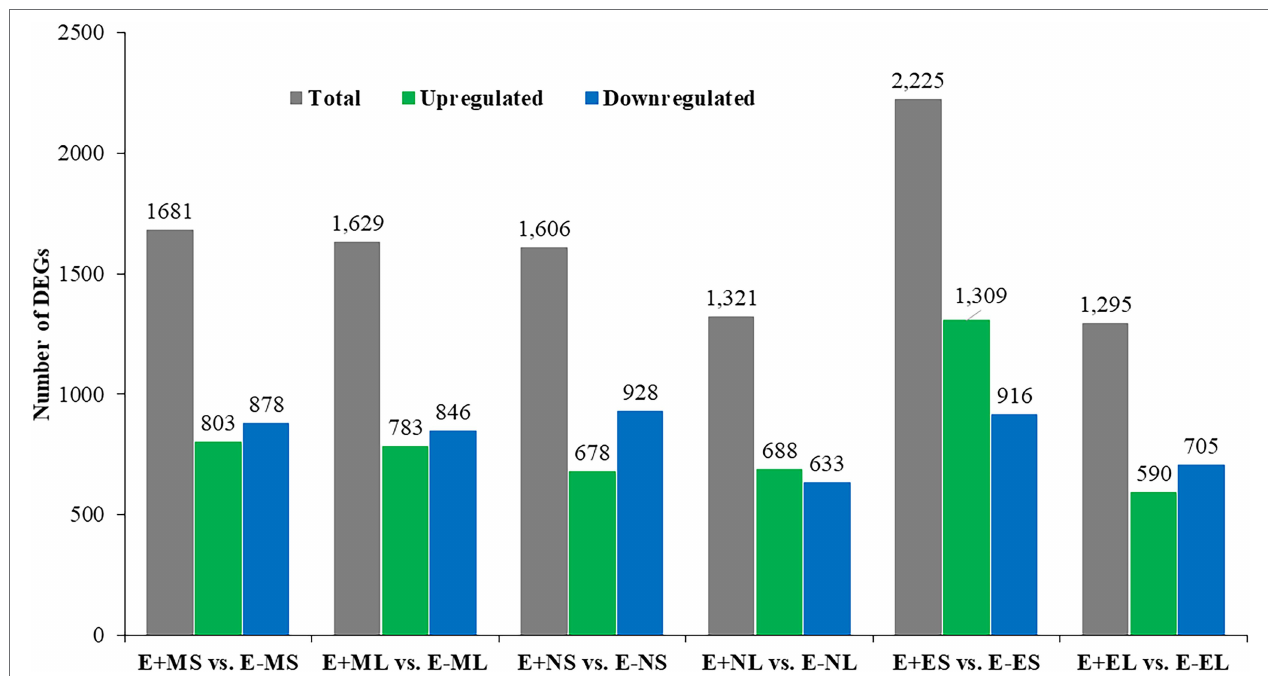
FIGURE 1 | Identification of differentially expressed genes between E+ and E − tissues under cold stress. Samples were: E+MS (endophyte positive, morning, pseudostem), E+ML (endophyte positive, morning, leaf blade), E+NS (endophyte positive, afternoon, pseudostem), E + NL (endophyte positive, afternoon, leaf blade), E+ES (endophyte positive, evening, pseudostem), E+EL (endophyte positive, evening, leaf blade), E − MS (endophyte-free, morning, pseudostem), E − ML (endophyte-free, morning, leaf blade), E − NS (endophyte-free, afternoon, pseudostem), E − NL (endophyte-free, afternoon, leaf blade), E − ES (endophyte-free, evening, pseudostem), and E − EL (endophyte-free, evening, leaf blade).